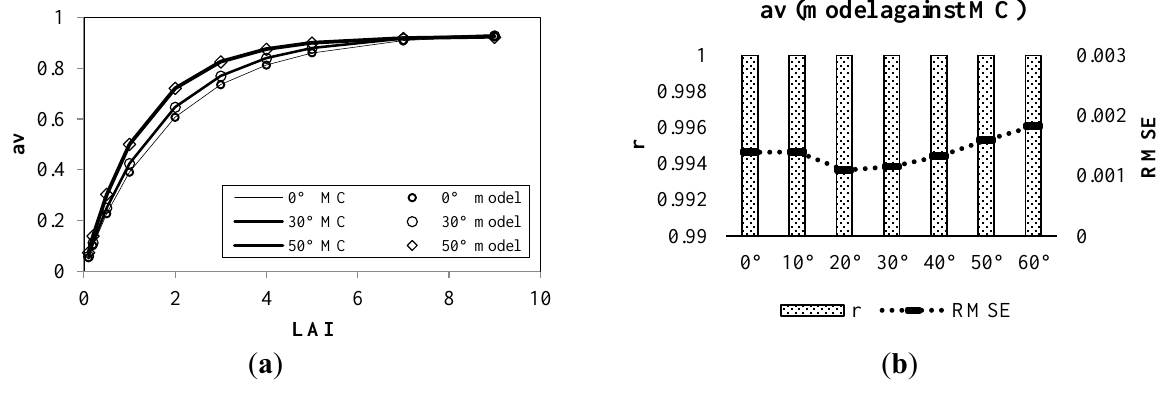
Figure 12. ( a ) Relationships between LAI and av as predicted by the model (circles and diamonds) and MC (lines) under different solar zenith angles at the green band; ( b ) the corresponding r and RMSE.